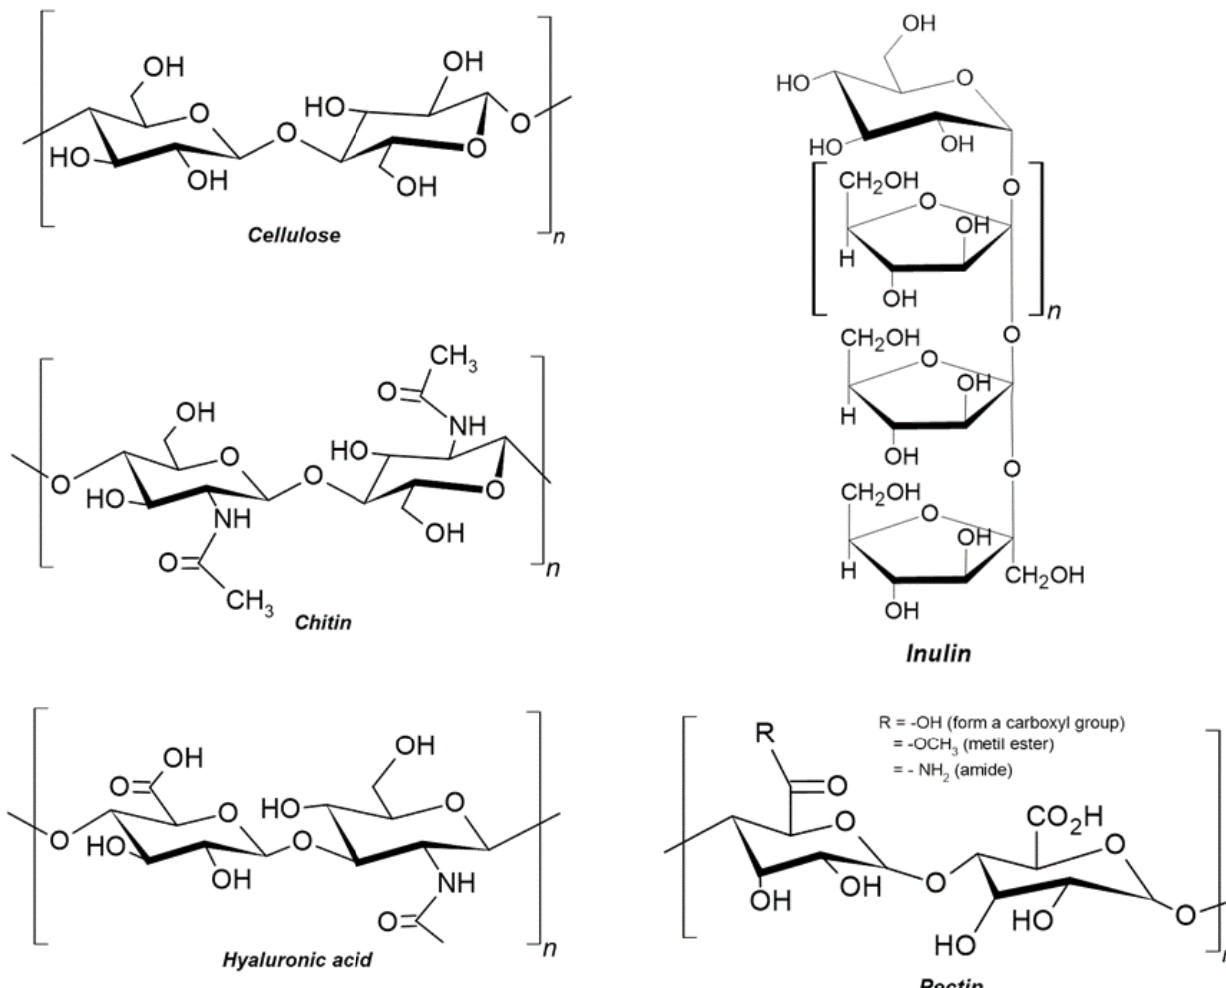
Figure 1. Chemical structures of cellulose, chitin, hyaluronic acid, inulin, and pectin, which are important polysaccharides highlighted in the present study.